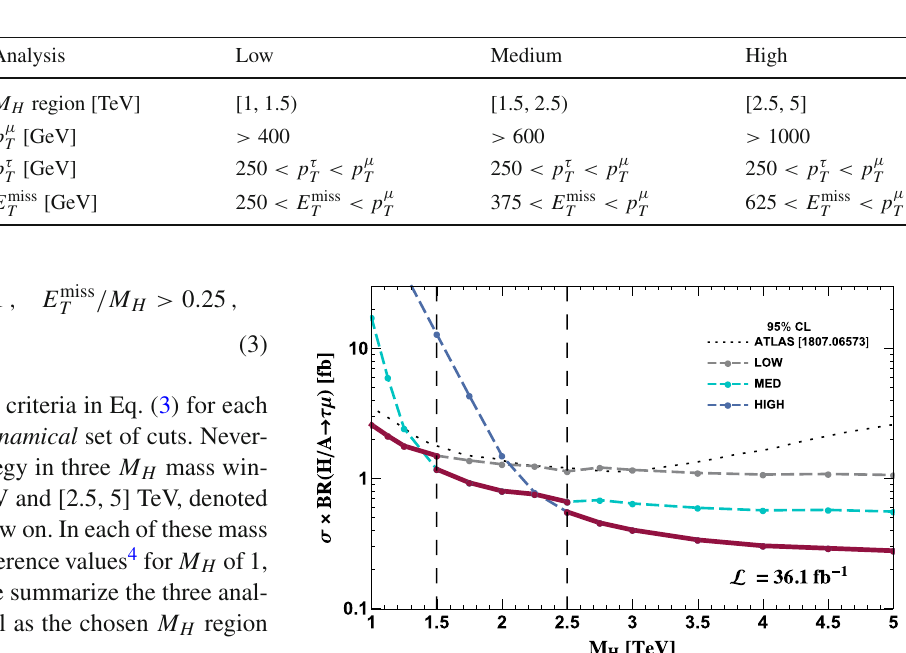
3 TeV) and the main reducible backgrounds W + jets and multijet, after (left) and T minimal requirements in Eq. (2), for a LHC center-of-mass energy of √ s = 14 TeV